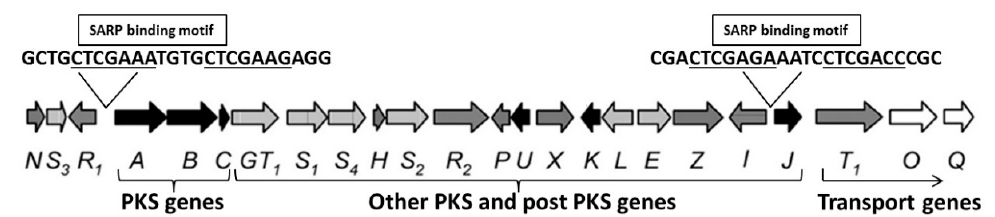
Figure 4. Gene organisation of the chartreusin biosynthetic gene cluster (BGC) (adapted from Xu et al., 2005). Two SARP binding motifs were identified within the chartreusin BGC. PKS, polyketide synthase.